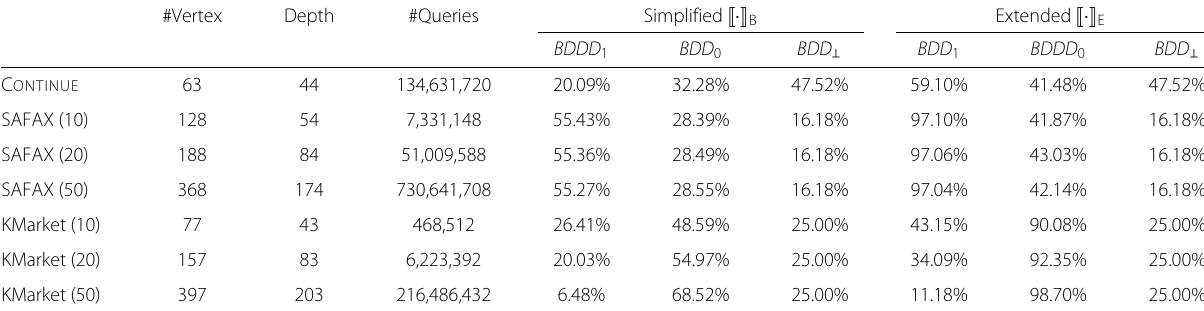
Table 7 BDD encoding constrained query space and percentage of queries that evaluate 1,0, (cid:6) for (cid:2) ⋅ (cid:3) B and (cid:2) ⋅ (cid:3)